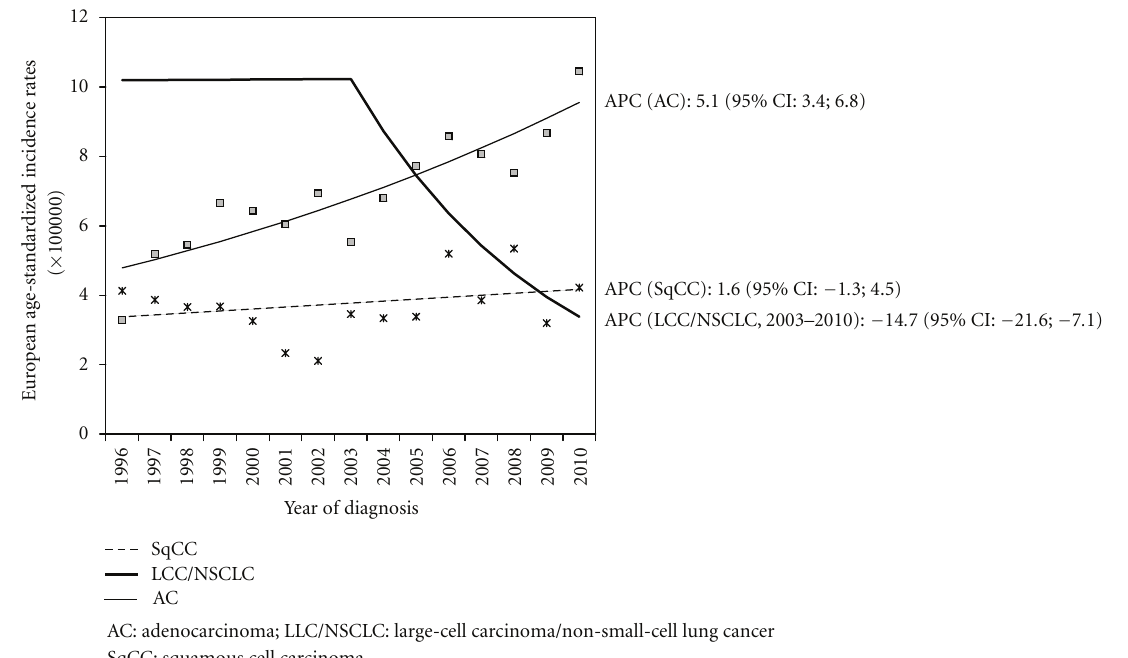
Figure 2: Trend in European age-standardised incidence rates of poorly di ff erentiated lung cancer histotypes: Ticino, 1996–2010.